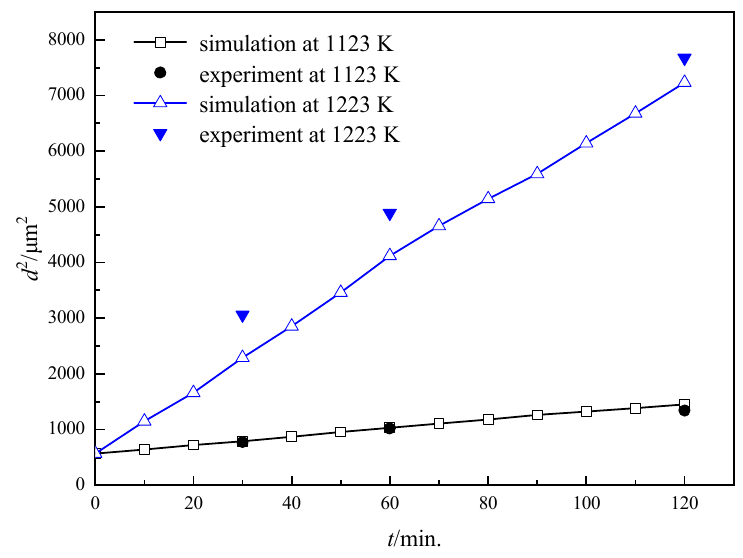
Figure 5. Comparison between simulated data and experimental results at 1123 K and 1223 K.